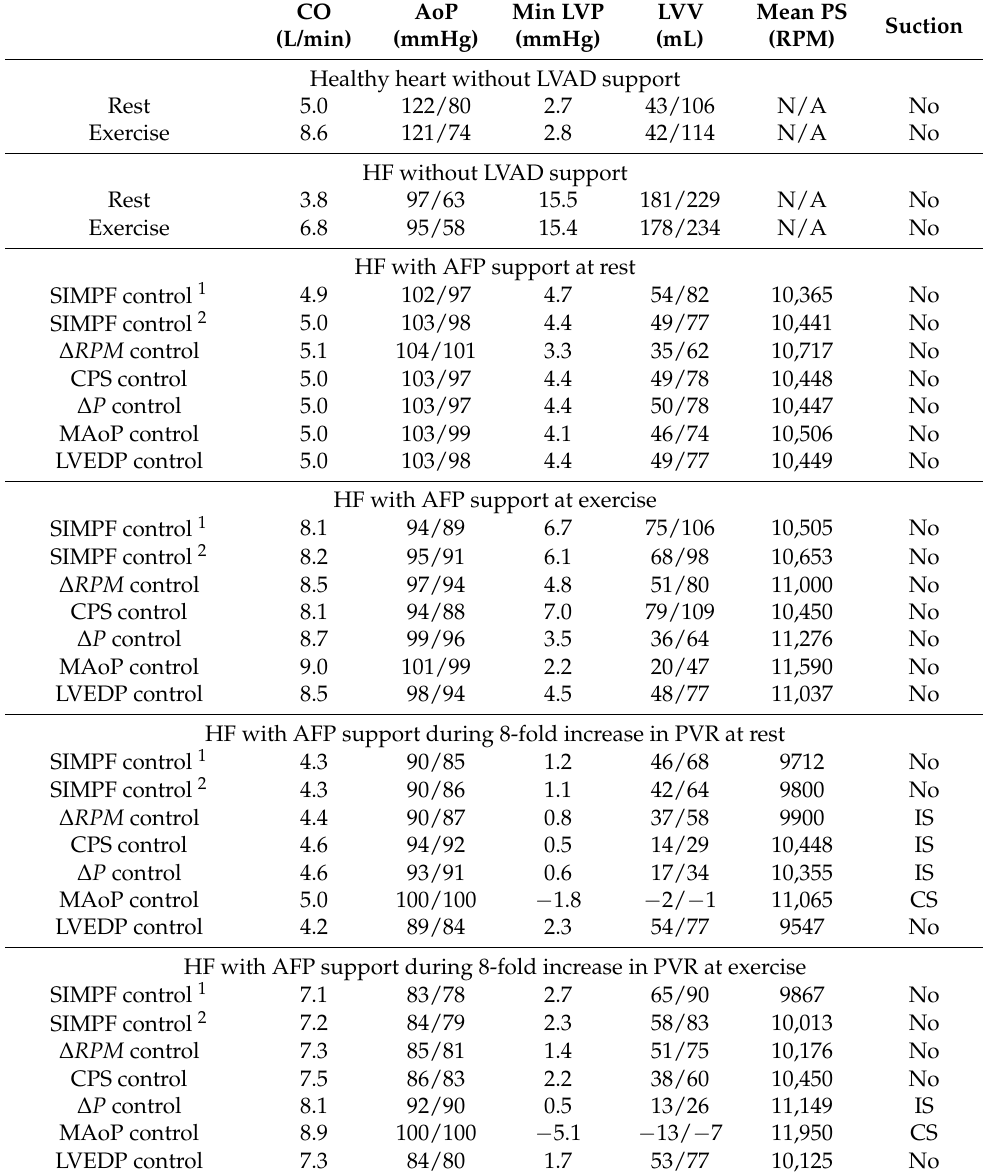
Table 1. Performance comparison among the proposed SIMPF control strategy and other control algorithms during various test conditions with